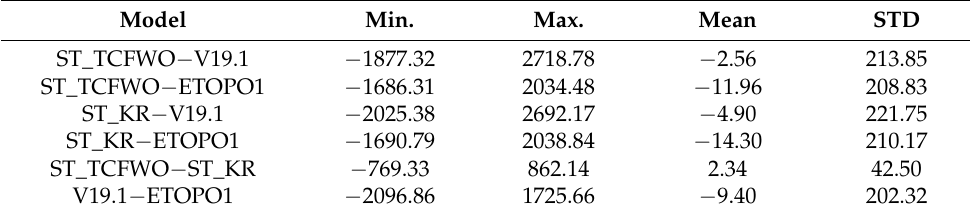
Table 4. Statistics of model differences, namely the differences between the four models. (unit: m). Model Min. Max. Mean STD ST_TCFWO − V19.1 − 1877.32